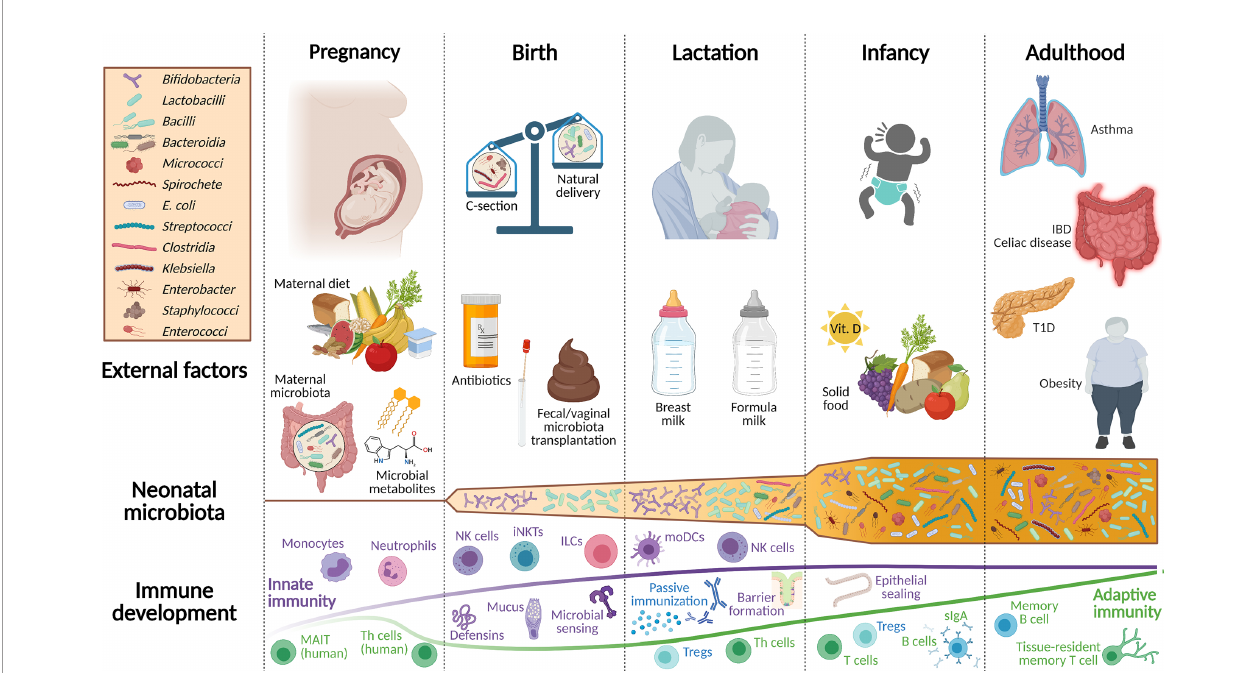
FIGURE 1 | Overview of environmental factors shaping the development of the newborn microbiota and mucosal immune system. Throughout pregnancy, fetal immune development is supported by microbial metabolites originating from the maternal microbiota and by dietary compounds. Innate immune cell populations, such as monocytes, ILCs, and neutrophils belong to the most affected immune cells at this stage. Only at birth, the emerging immune system of the newborn is confronted with live bacteria and thus, is still dependent on maternal protection, which is ensured through breastfeeding. Apart from passive immunization via breast milk, neonatal iNKTs, NK cells, ILCs, and the gastrointestinal epithelial barrier protect against invading pathogens and promote the bene fi cial interplay with the neonatal microbiota. The adaptive immune system in mice develops primarily postnatally, while a component of adaptive immunity is already present in the human fetus. Birth mode, feeding, and the intake of antibiotics are additional factors that shape the early life microbiota and the neonatal immune system. During the subsequent weaning reaction, when solid food is introduced to the infant ’ s diet, a tremendous shift occurs in its intestinal bacterial community composition. Consequently, the microbiota is no longer represented by Bi fi dobacteria and Lactobacilli, but increases in metabolomic diversity evolving to a more adult-like microbiota that is established during this early period of life. This period is often also called the window of opportunity since particularly during this time, external cues have a profound impact on life-long health, the evolving microbiota, and the mucosal immune system. IBD, in fl ammatory bowel disease; sIgA, secretory immunoglobulin A; ILCs, innate lymphoid cells; iNKTs, invariant natural killer T cells; MAIT, mucosal-associated invariant T cells; moDCs, monocyte-derived dendritic cells; NK, natural killer cells; Th cells, T helper cells; Treg, regulatory T cells; T1D, type 1